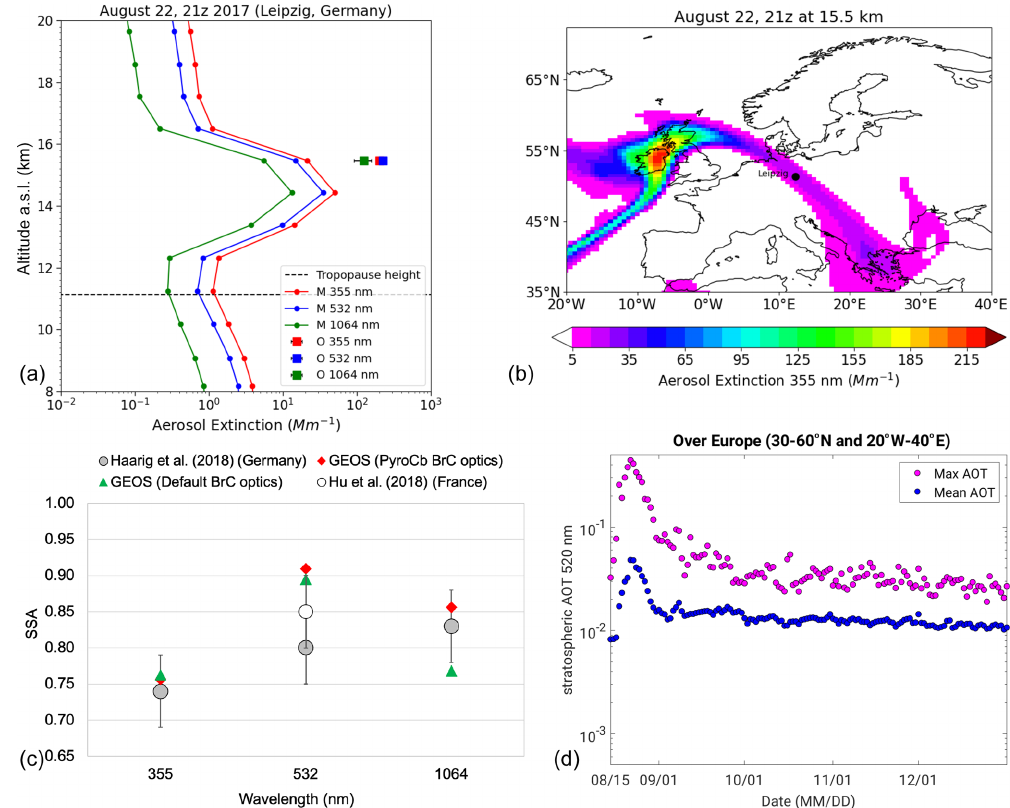
Figure 3. Evaluation of the simulated aerosol absorption and extinction with ground-based lidars. (a) Model-simulated aerosol extinction profiles (M) and peak extinctions based on lidar observations (O) for the 15–16km layer reported in Haarig et al. (2018) at Leipzig, Germany, on 22 August 2017 at 21:00Z. (b) The spatial distribution of simulated aerosol extinctions at 355nm, around the Leipzig location for the same time. (c) Comparison of single-scattering albedo (SSA) retrieved from Raman Lidars (markers with error bars) and simulated by the GEOS model (colored markers) assuming different BrC optics for the stratospheric smoke aerosol layer observed over Europe (Haarig et al., 2018; Hu et al., 2019) after 10–15d of the pyroCb injections. (d) Evolution of model-simulated stratospheric (mean and maximum) aerosol optical thickness (AOT) over Europe from mid-August to end of